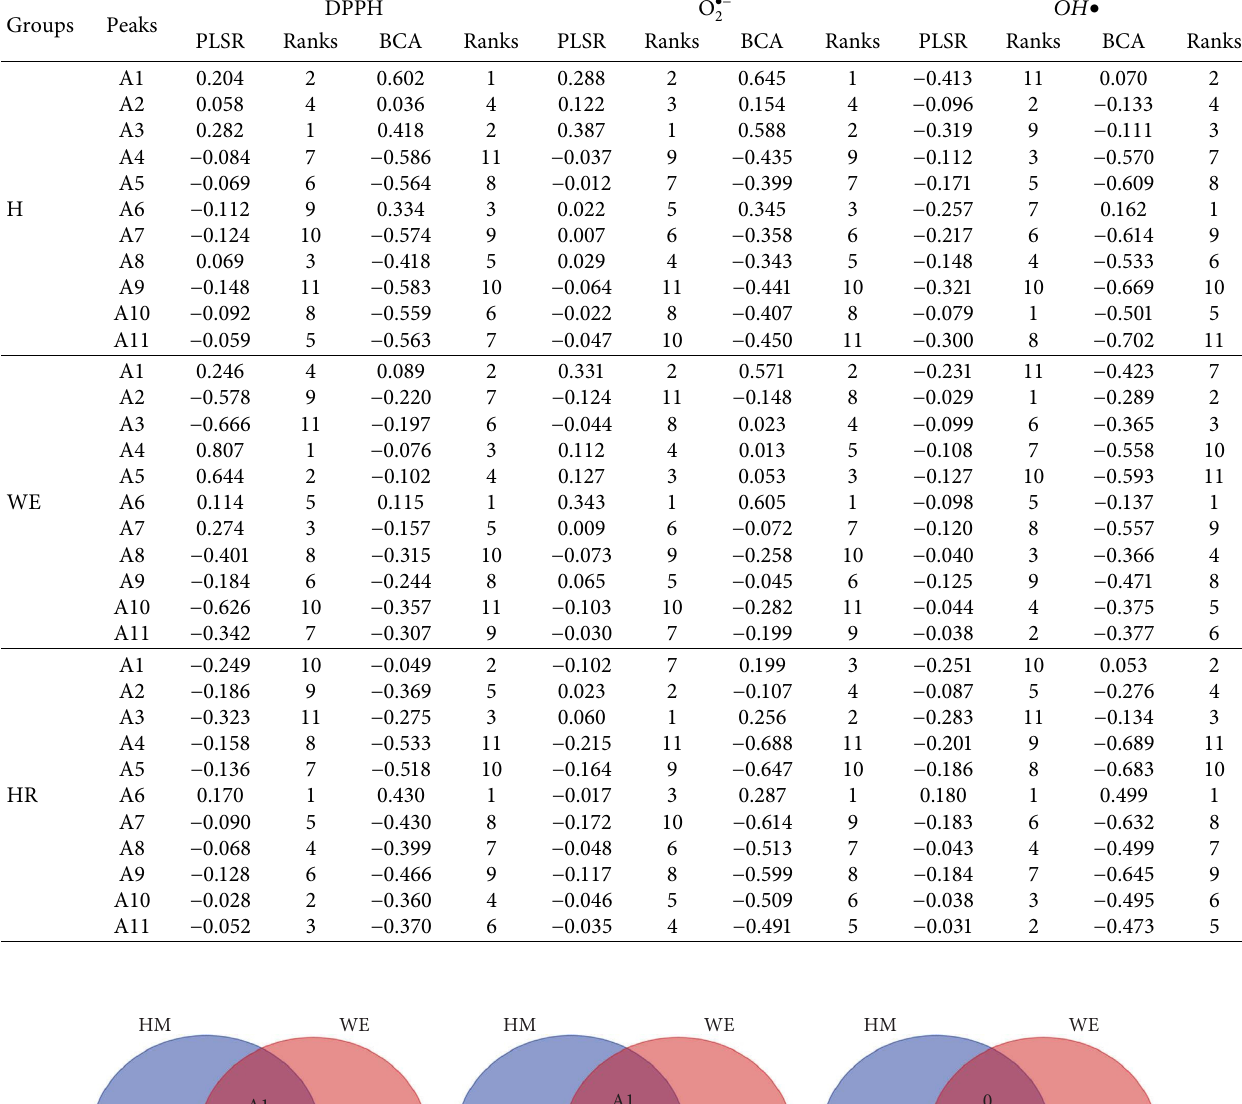
Table 4: Correlation coefcients of PLSR and BCA models for the peak area and antioxidant assay. Groups